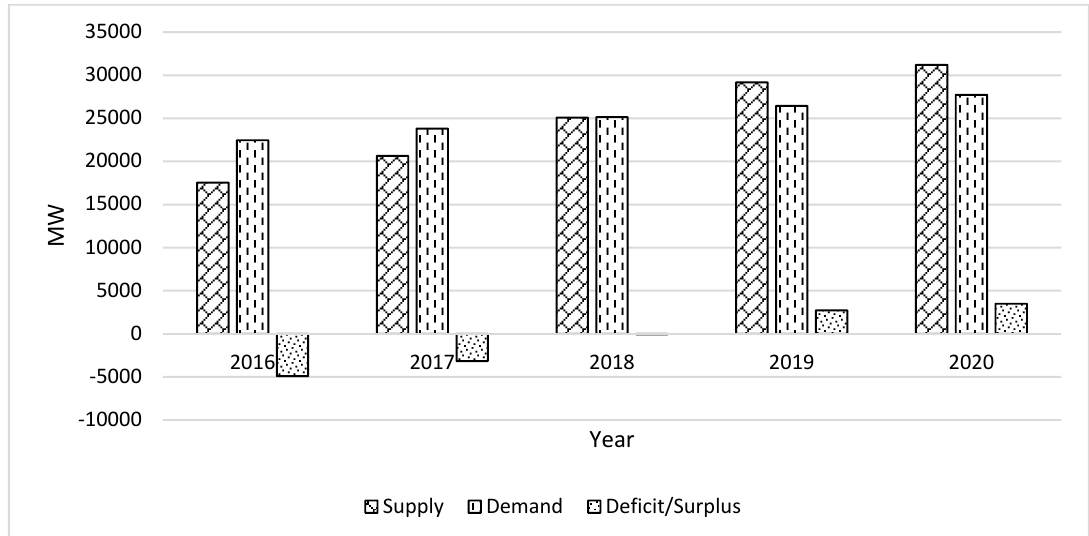
Figure 2. Projected electricity demand and supply for 2016–2020.